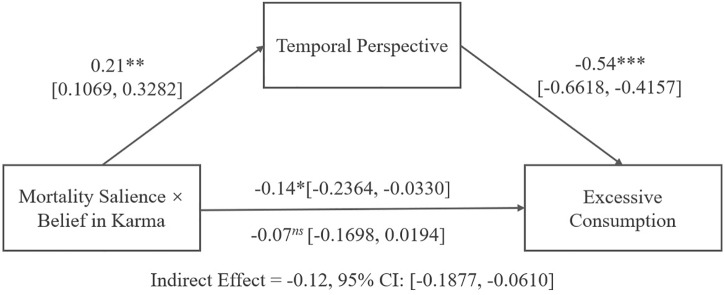
Study 2 results: mediation analysis with temporal perspective as a mediator. nsp > 0.05, ∗p < 0.05, ∗∗p < 0.01, ∗∗∗p < 0.001.